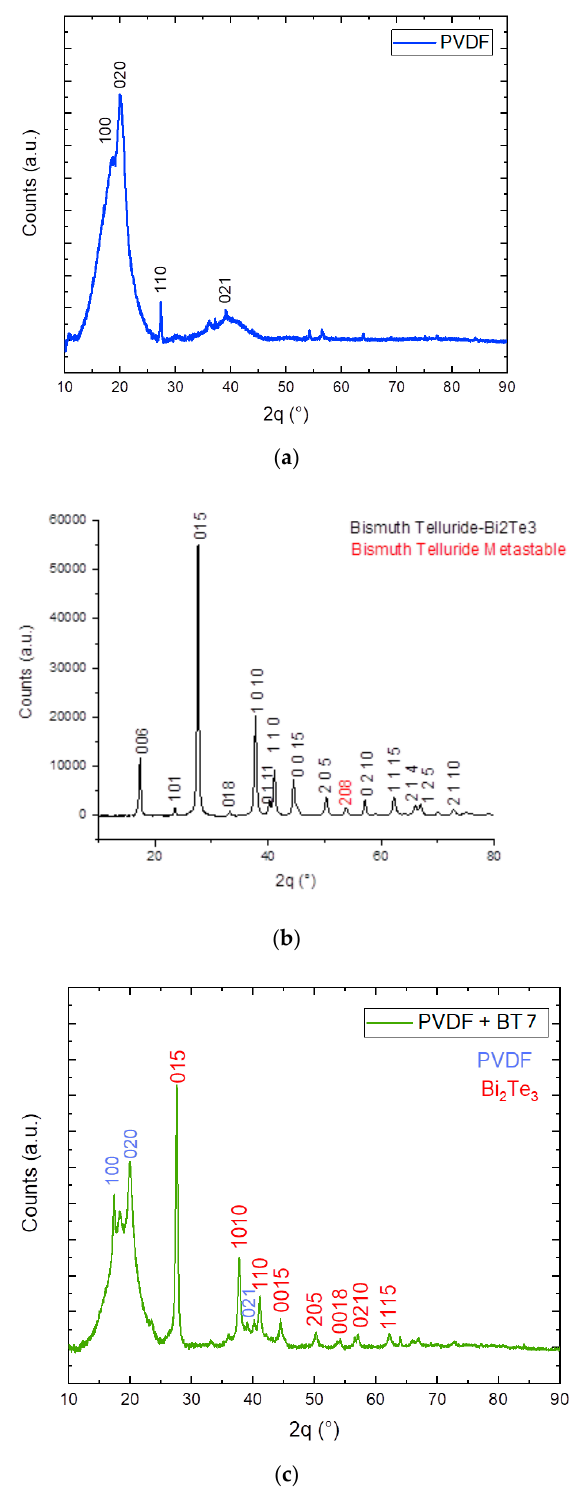
Figure 2. XRD patterns for ( a ) pristine PVDF, ( b ) Bi 2 Ti 3 flakes and ( c ) PVDF/BT (7%) membrane. TEM images for selected graphene and bismuth telluride flakes exfoliated via WJM are shown in Figure 3a,b, respectively. They confirmed the presence of few layers of Bi 2 Te 3 (BT) and graphene (G) in the solvent residues. Graphene flakes are larger and more regular than Bi 2 Te 3 flakes (which, on the contrary, show irregular and wrinkled geometries). In particular, graphene and Bi 2 Te 3 flakes have a lateral size of about